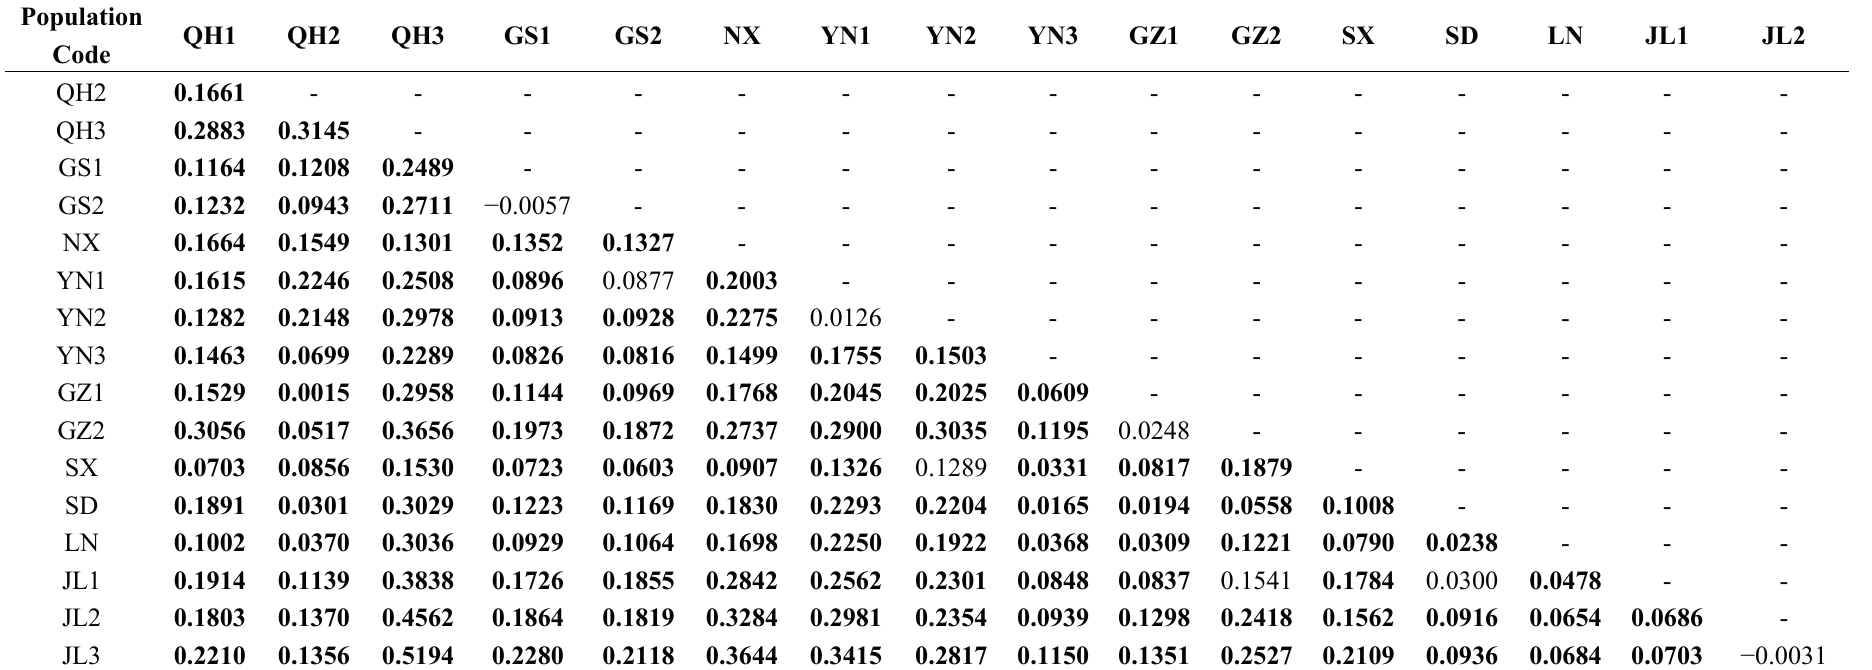
Table 3. Population pairwise Fst (genetic distance)